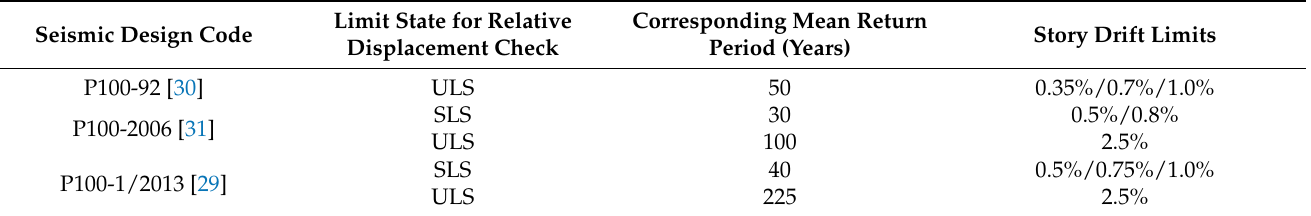
Table 2. The limit states, story drift limits and corresponding mean return periods for the relative displacement checks required by the different generations of the Romanian seismic design